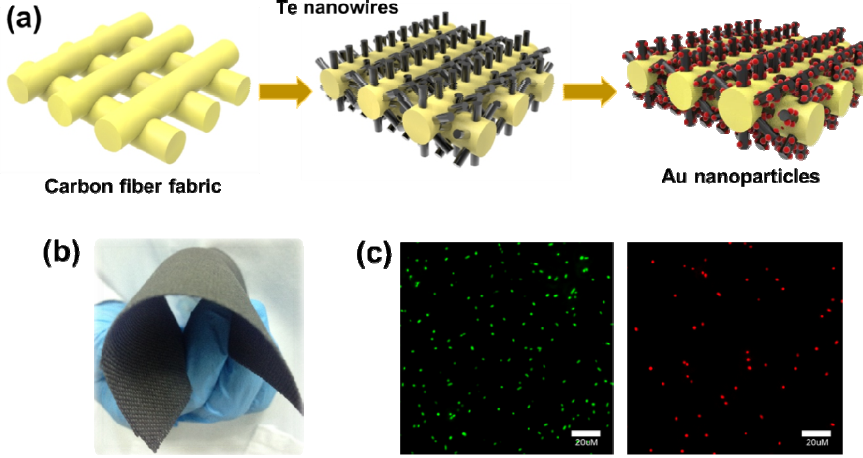
Figure 1. ( a ) Illustration of the growth of Te and Te-Au NWs on carbon fiber fabrics; ( b ) Photograph of the as-prepared carbon fiber fabrics with Te-Au NWs; ( c ) Fluorescence images of live (green) and dead (red) bacteria.